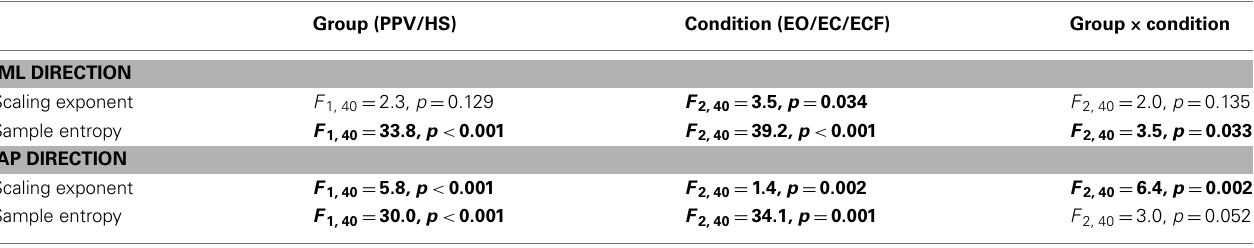
Table 1 | Results of the two-wayANOVA on the scaling exponent α and SEn of the CoP displacement in the medial-lateral (ML) and the anterior-posterior (AP) plane. Group (PPV/HS) ML